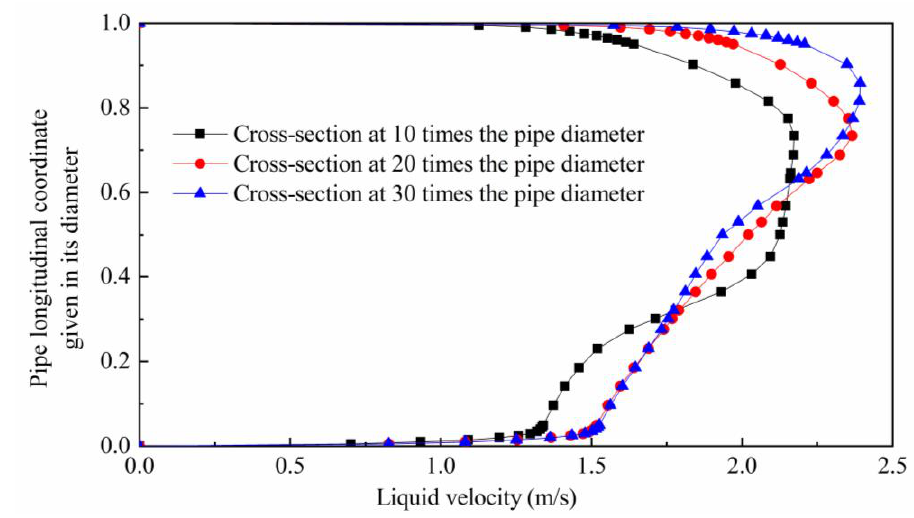
ff erent cross-sections, v